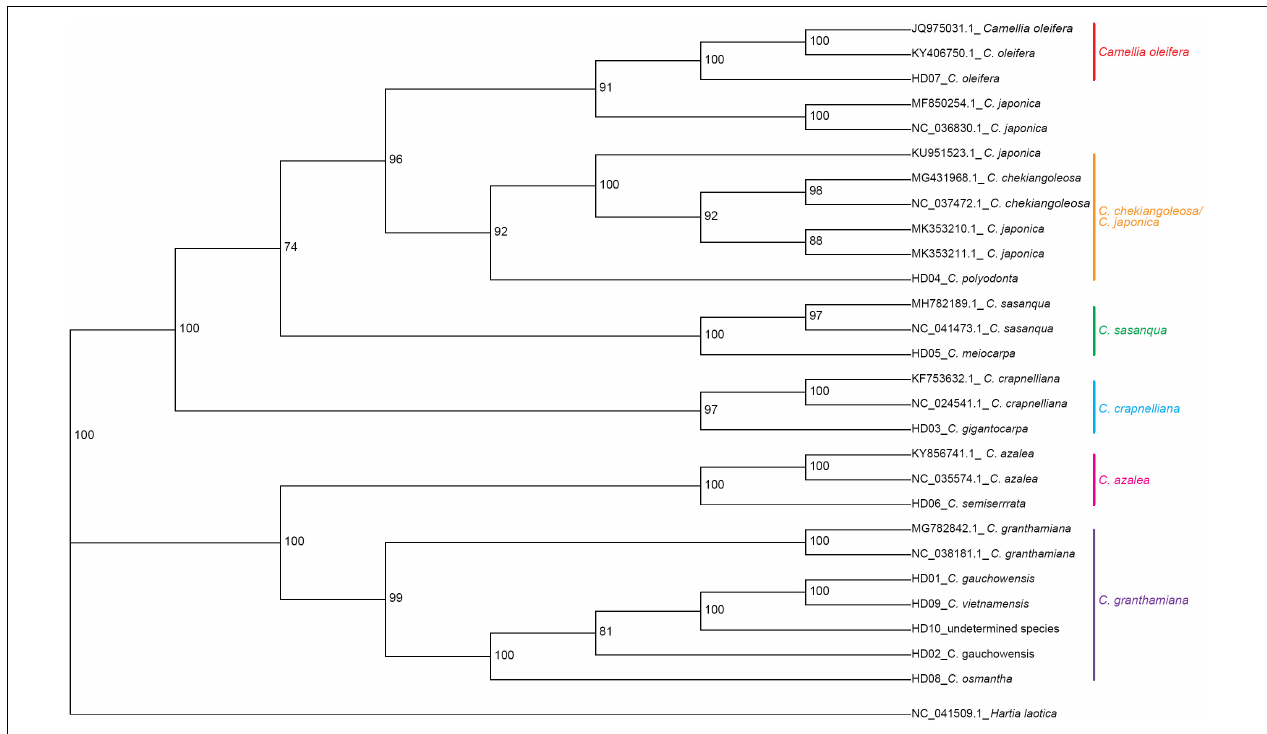
FIGURE 5 | Phylogenetic tree of 13 samples based on chloroplast genome (cpDNA) constructed using the maximum likelihood method (ML).